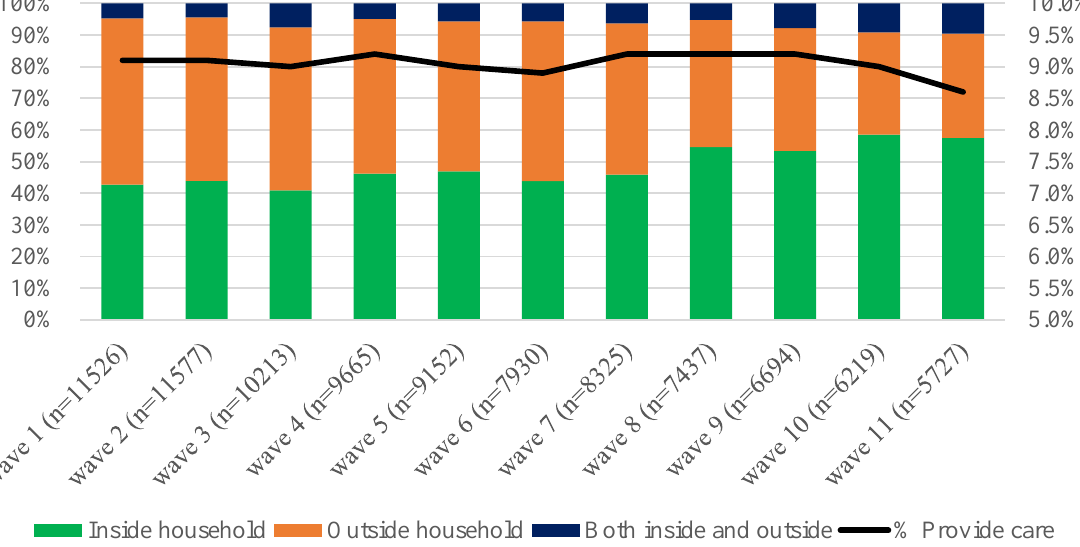
Figure 1. Prevalence of care among people aged 16 – 29 and distribution by place of care — UKHLS waves 1 – 11. Source: UK Household Longitudinal Study (UKHLS), Waves 1 – 11. Weighted data. Samples restricted to respondents aged 16 – 29 at each wave. Notes: the values on the right refer to the prevalence of care whereas those on the left to the distribution by place of care.